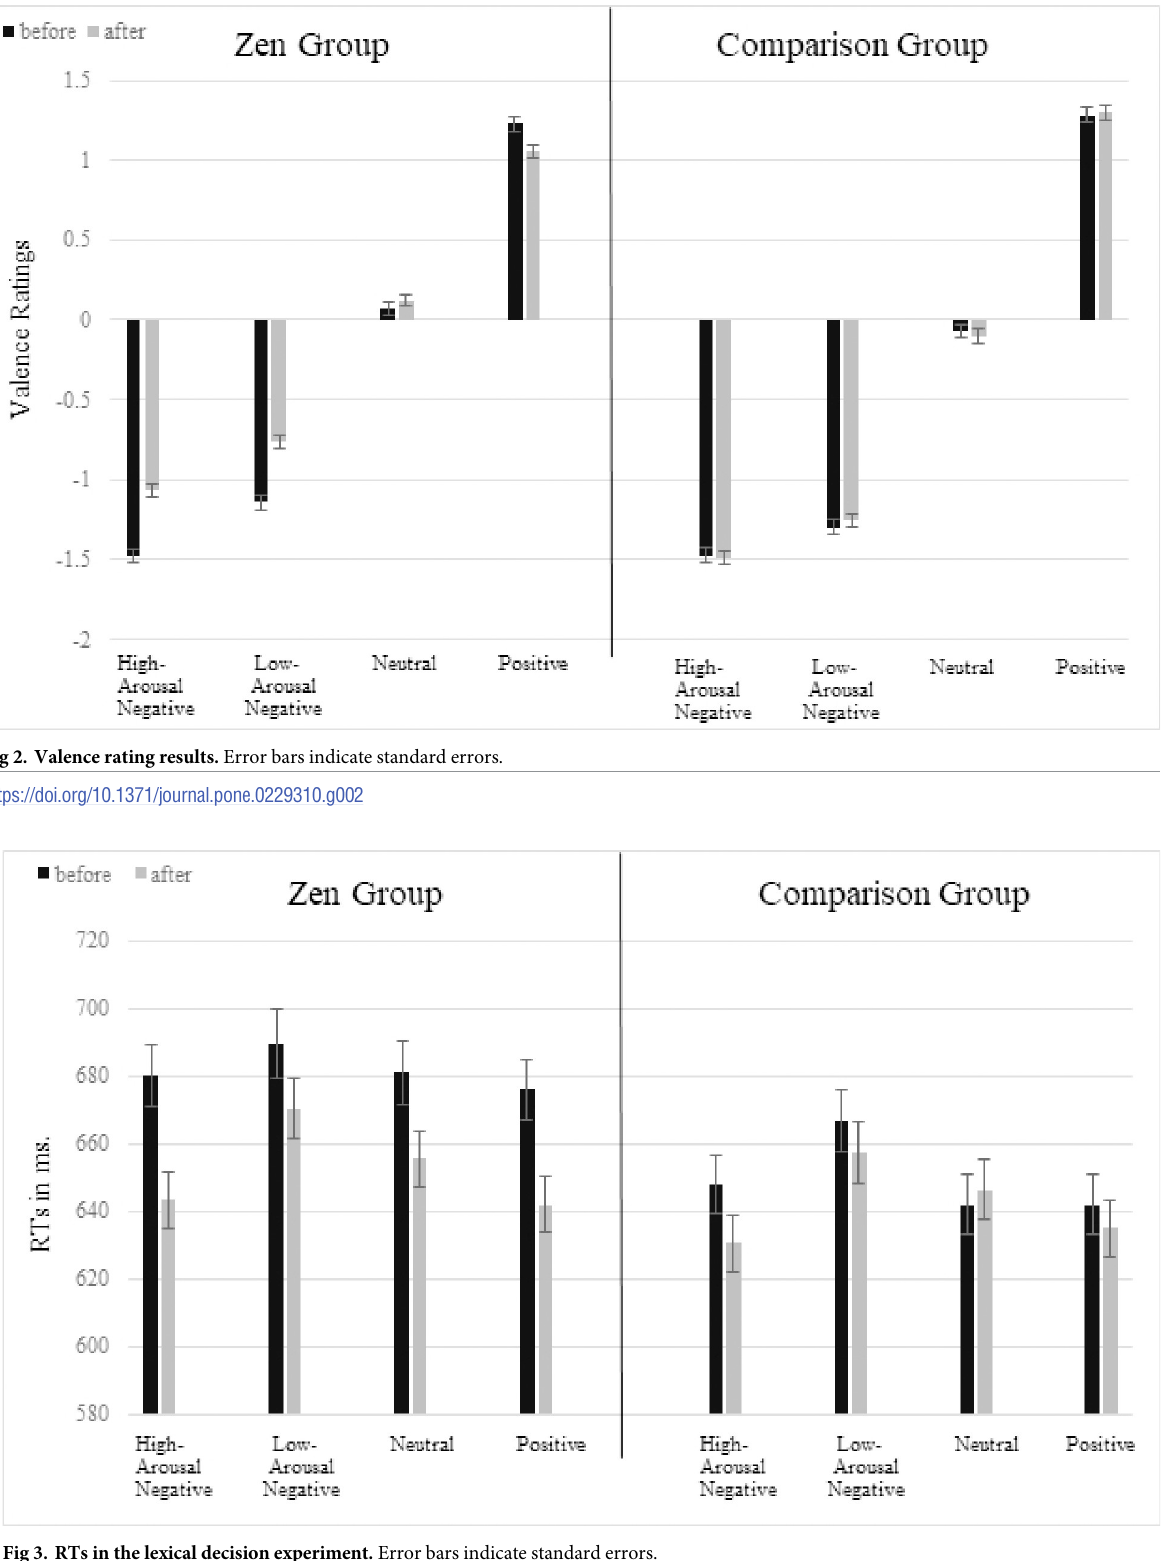
PLOS ONE | https://doi.org/10.1371/journal.pone.0229310 February 19,